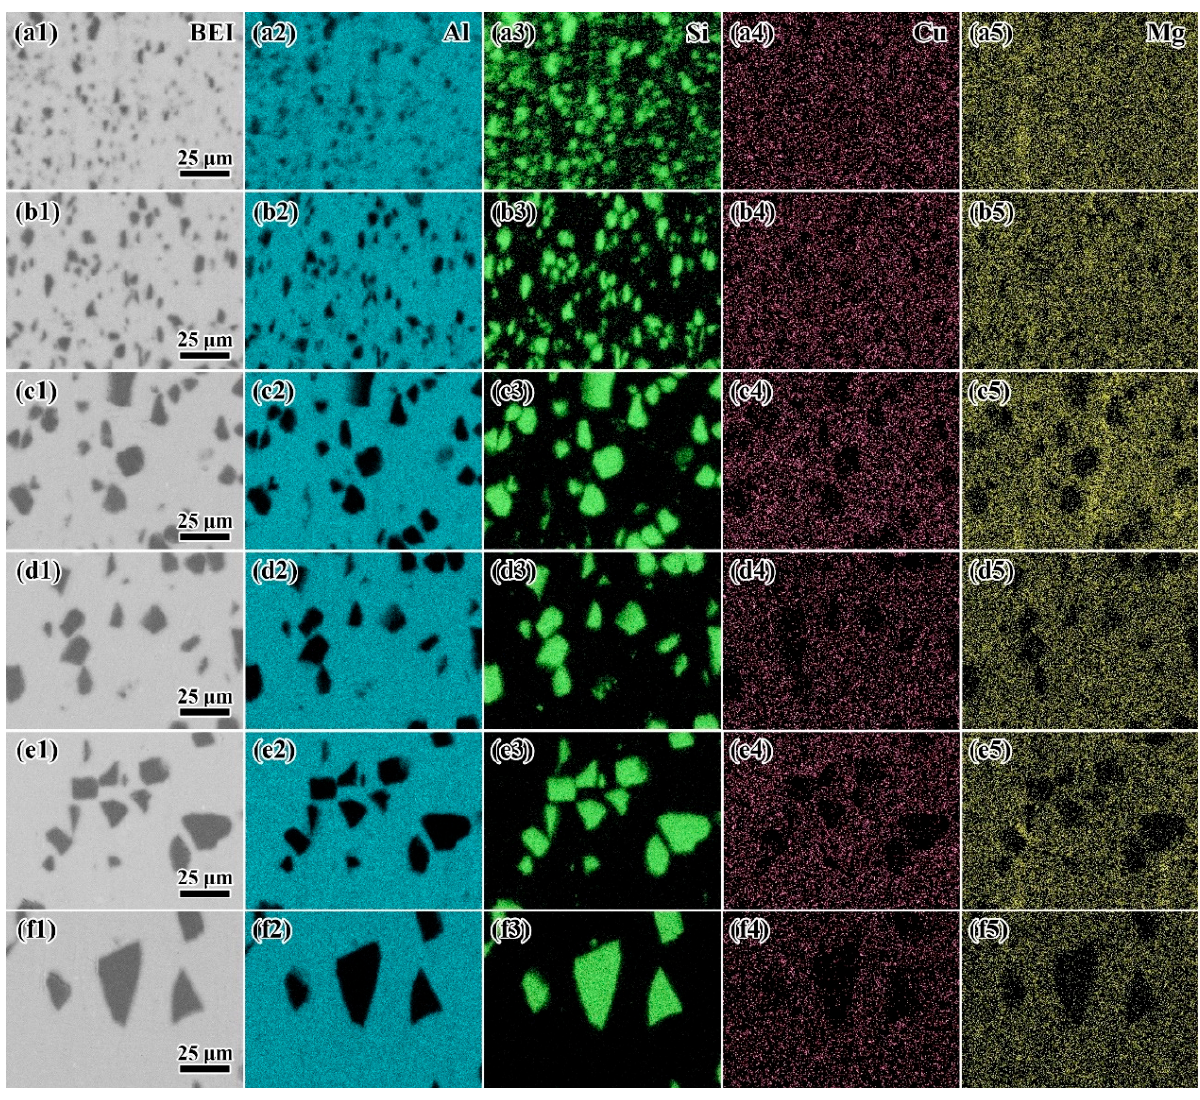
Figure 3. The typical EDS mapping of ( a ) H-4, ( b ) H-8, ( c ) H-12, ( d ) H-15, ( e ) H-20, and ( f ) H-30. The results of ( 1 ) backscattered electron image, EDS mapping of ( 2 ) Al, ( 3 ) Si, ( 4 ) Cu, and ( 5 ) Mg are shown in every group.